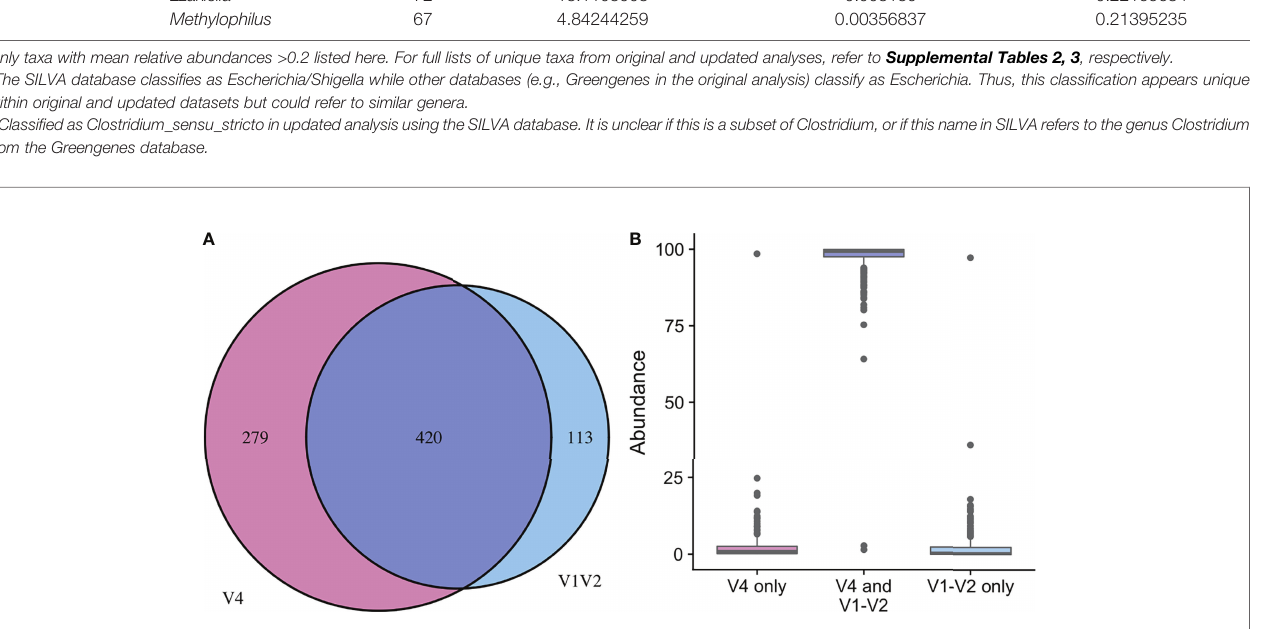
Figure 5 . Paired abundances from V1-V2 and V4 regions from